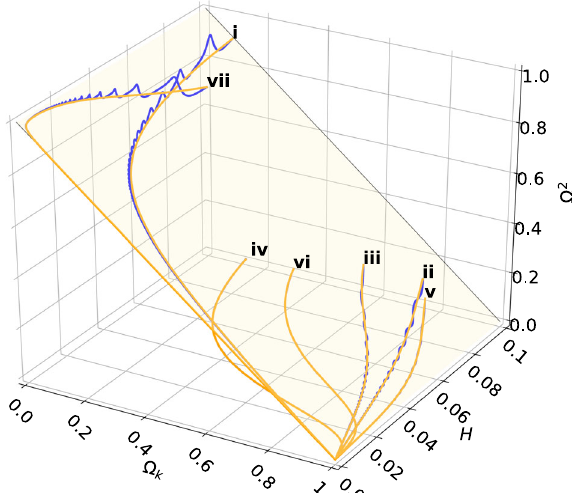
Fig. 24 Some solutions of the full system (71) (blue) and time-averaged system (107) (orange) for the FLRW metric with negative curvature ( k = − 1) when γ = 2. We have used for both systems initial data sets presented in the Table